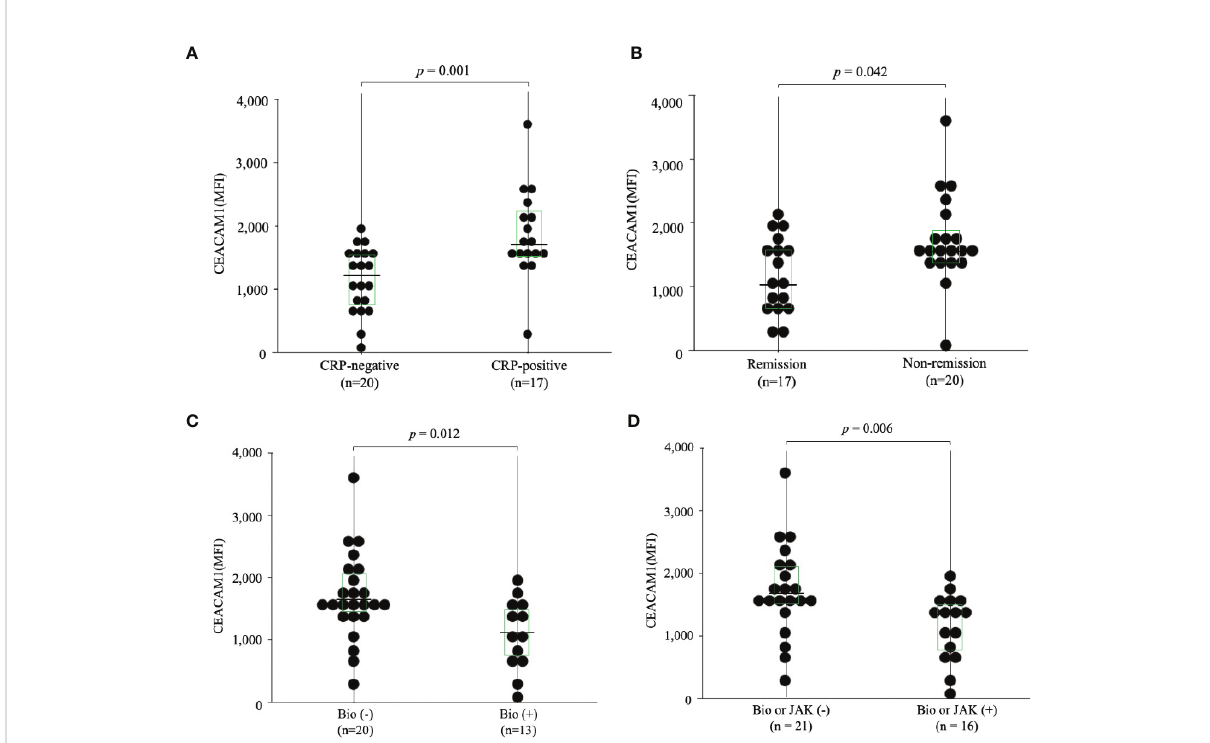
FIGURE 3 The expression of CEACAM1 on peripheral blood neutrophils in RA patients. (A) The expression of CEACAM1 on peripheral blood neutrophils isolated from RA patients with (n=17) or without (n=20) elevated serum in fl ammatory marker (CRP >0.30 mg/dL). The MFI of CEACAM1 positive neutrophils in RA patients with elevated serum in fl ammatory marker was signi fi cantly higher compared to RA patients without them. (B) The expression of CEACAM1 on peripheral blood neutrophils in RA patients with or without remission according to SDAI. The MFI of CEACAM1 in the non – remission group was signi fi cantly higher compared to the remission group. (C, D) The MFI of CEACAM1 was signi fi cantly higher in the RA patients who used Bio or JAK inhibitors than in the non-used patients. Statistical signi fi cance was determined by the Mann – Whitney U test. Horizontal bars and squares indicate the median and IQR, respectively. RA, rheumatoid arthritis; CRP, C – reactive protein; MFI, mean fl uorescence intensity; Bio, Biologics; JAK, Janus kinase; IQR, interquartile